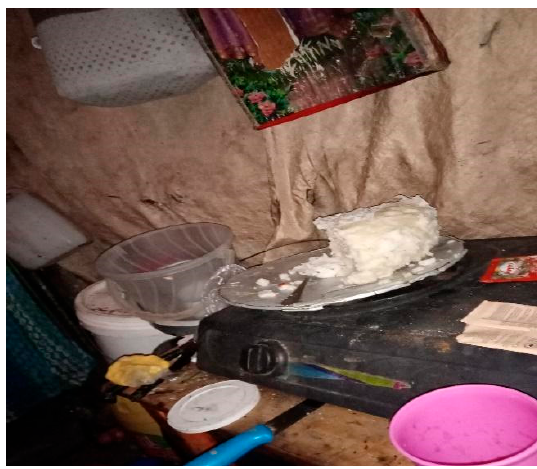
Figure 3. “This photo was taken on a day when I had gone to work but I wasn’t feeling well, so I just washed utensils for one person then bought rice which we ate on that day. Before we were not eating like this—everyone was eating from their own plate—but nowadays, we are sharing because it is not much. So you just put there for everyone to eat. Sometimes we even do not have any food to eat. The first days when my mum fell sick, the kids had not gotten used to eating less food but now, they are used to it. When you tell them that there is no lunch, they will just go out to play. Sometimes they will just sleep hungry since they are used to it” (Violet, 17-year-old girl, Korogocho).